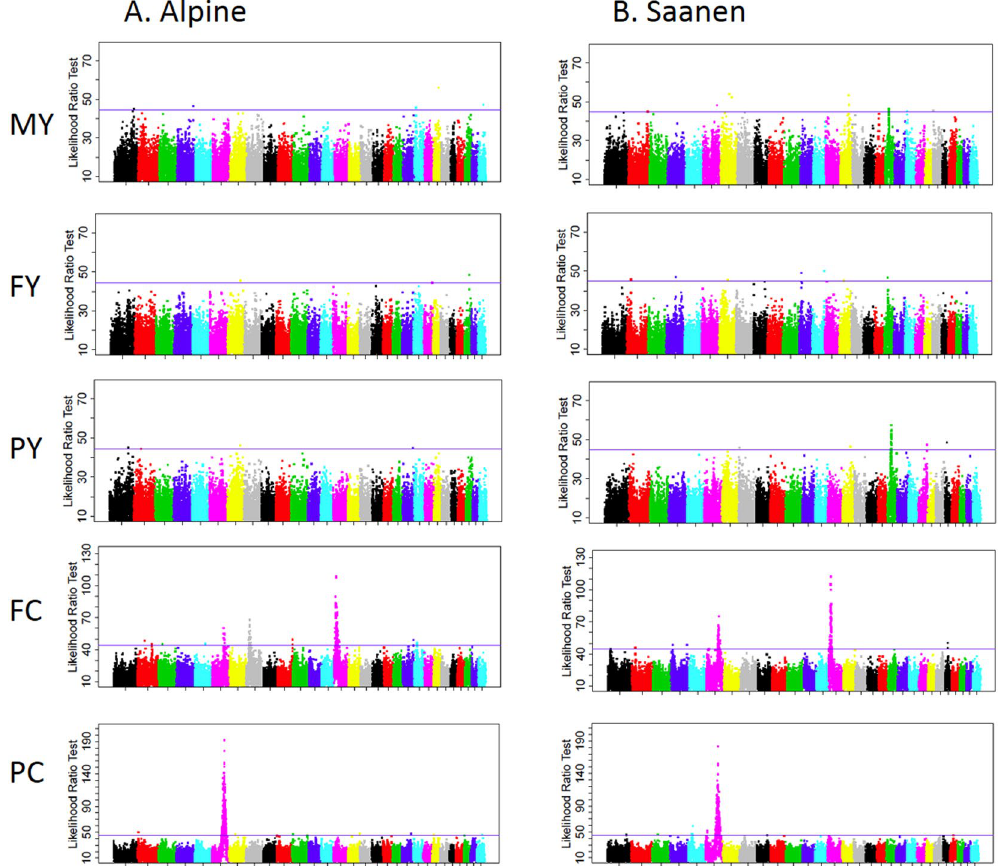
Figure 1. Manhattan plot of likelihood ratio test profiles for five milk production traits: milk yield (MY), fat yield (FY), protein yield (PY), fat content (FC) and protein content (PC) in Alpine ( A ) and Saanen goat breeds ( B ). The solid horizontal lines represent the 5% genome-wide thresholds (averaged over the 29 autosomes).